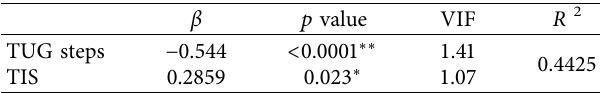
Table 3: Multiple regression analysis for the prediction of mini- BESTest score improvements.